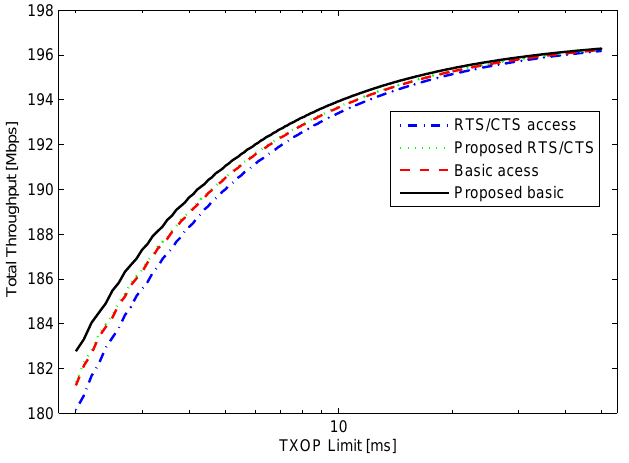
Figure 6. Throughput for n = 10, r’ = 54 Mbps, r = 300 Mbps, and BER =